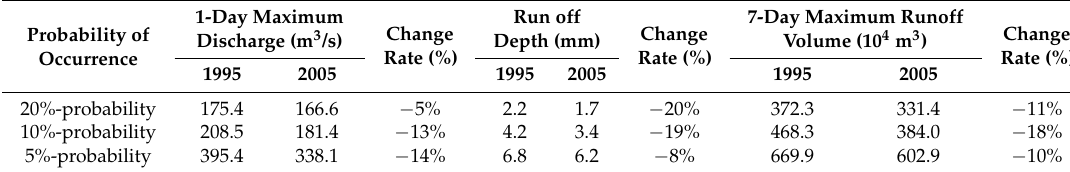
Table 7. The characteristics of floods with three probabilities in 1995 and 2005 land use scenarios. Probability of Occurrence